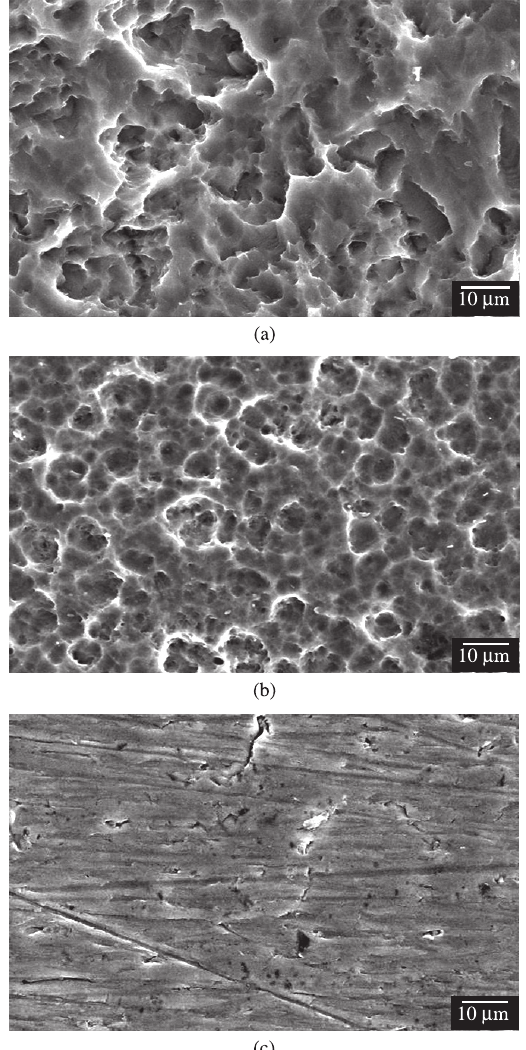
Figure 2. Micrographs of Ti obtained after 4 days immersion in the citrate buffers containing 0.1 M NaF, magnification × 1000; a) pH 2.0; b) pH 5.0; and c) pH